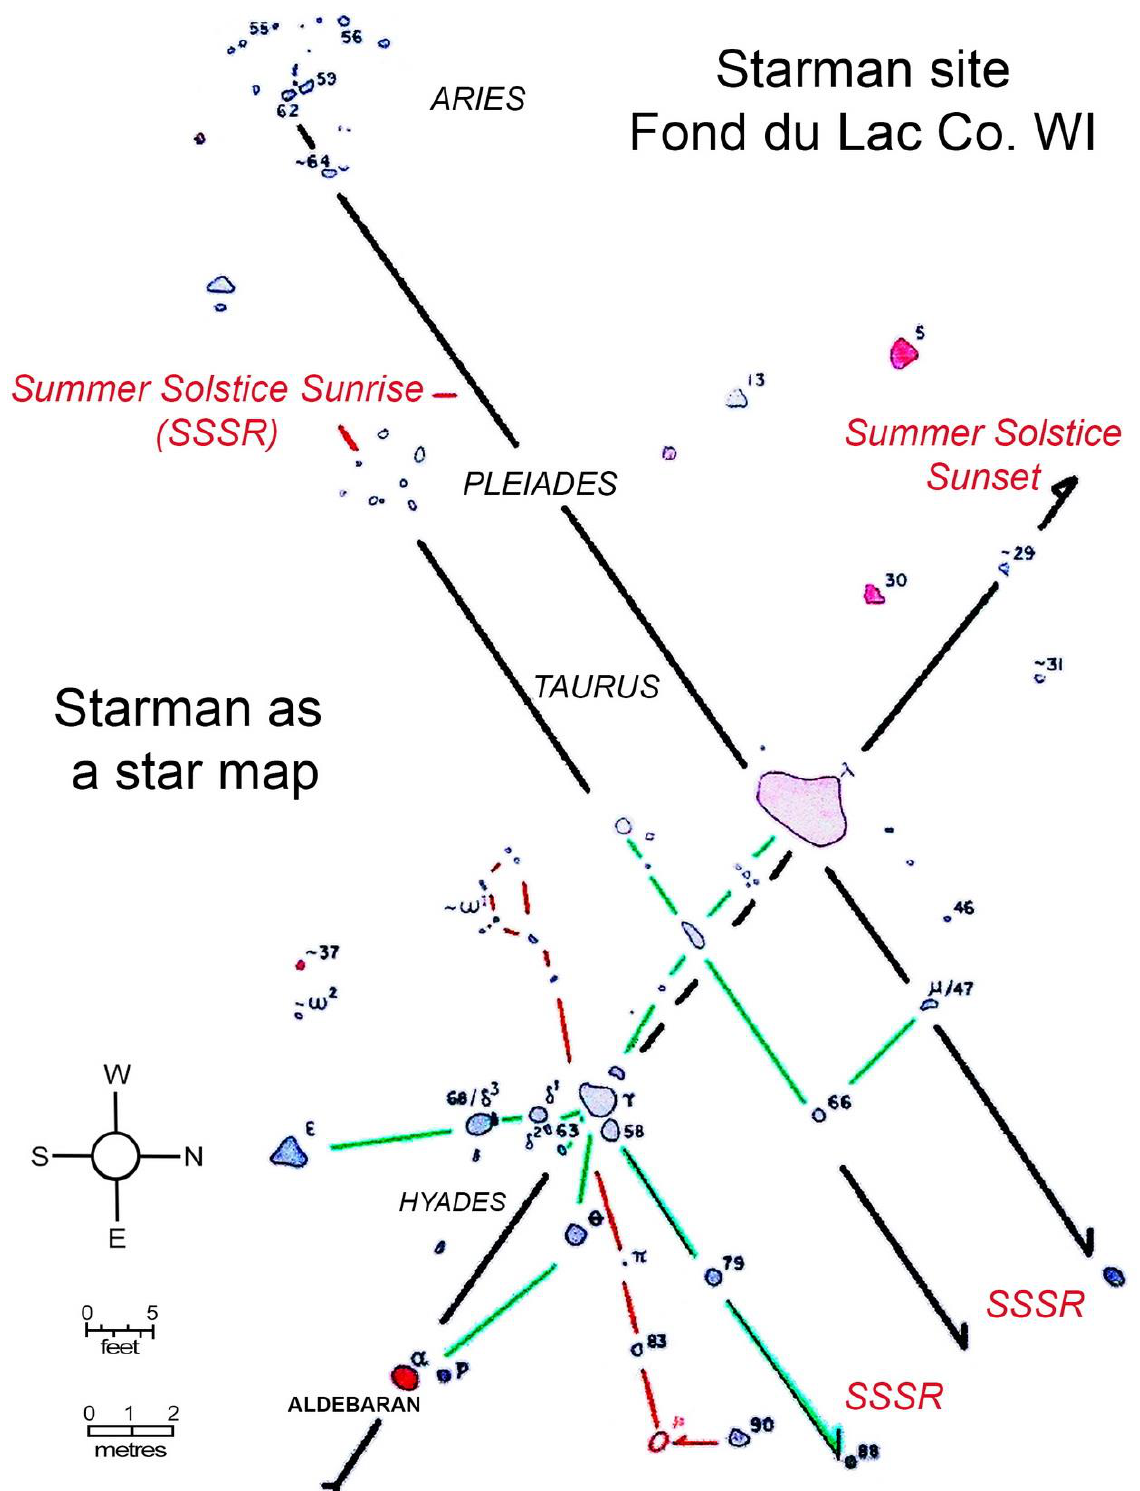
Figure 2. Partial map of the Starman site as a star map illustrating its astronomical attributes. Note the red- coloured, summer solstice sunrise aligned, bison-shaped headstone (see Figure 9), the parallel, multiple summer solstice sunrise alignments, and the rock-for-star designations of the individual rocks directly compared to a star chart. A red coloured rock was strategically placed to indicate the red star Aldebaran. The rock in the ‘pelvis’ of the Starman is a recumbent Bison Stone also aligned to face the summer solstice sunrise (Figure 10). All the proposed solstice alignments have been observed and photographically confirmed. Each exhibits the full solar disk shift consistent with 3500-4000 years of the shift of the obliquity of the